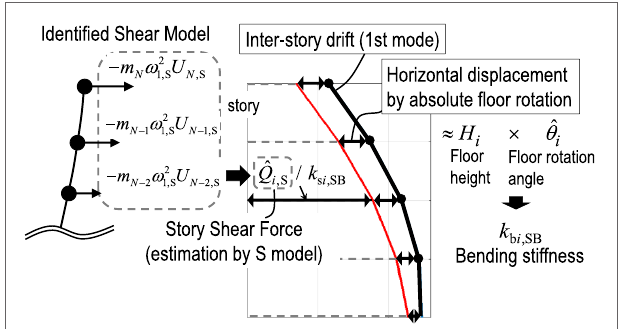
FIGURE 7 | Identification of bending stiffness using first-mode shapes of shear model and shear-bending model .